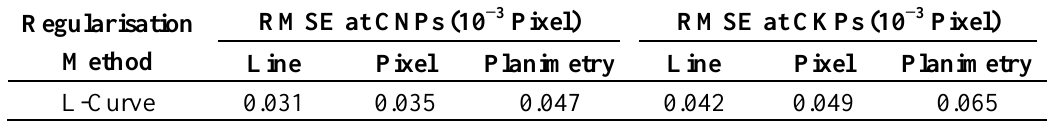
Table 1. Results for rational function modelling by an independent method. RMSE: root mean square error, CNP: control point, CKP: check